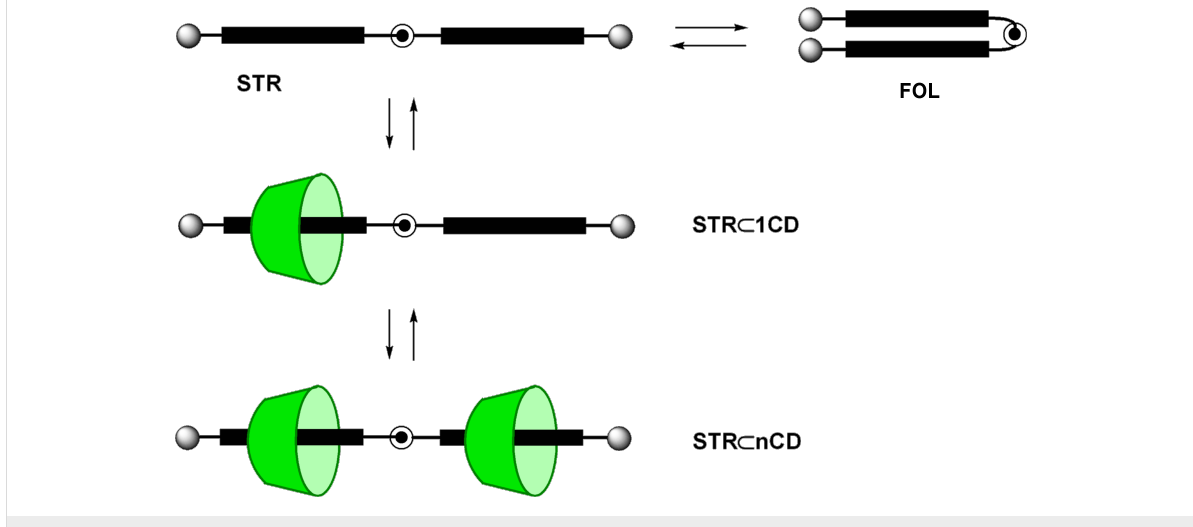
Scheme 12: Formation of pseudorotaxanes from AR 32a and cyclodextrines.